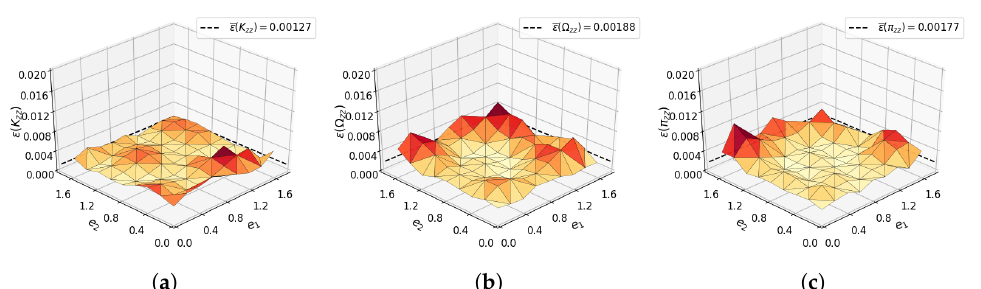
Figure 9. Modified relative errors ε are presented, with respect to e 1 and e 2 , for the examples of tensor components K zz , Ω zz and Π zz , shown at ( a – c ) sections respectively. Parameters λ 1 and λ 2 are fixed to 5 and 3. The average error for the plot is displayed in the top right